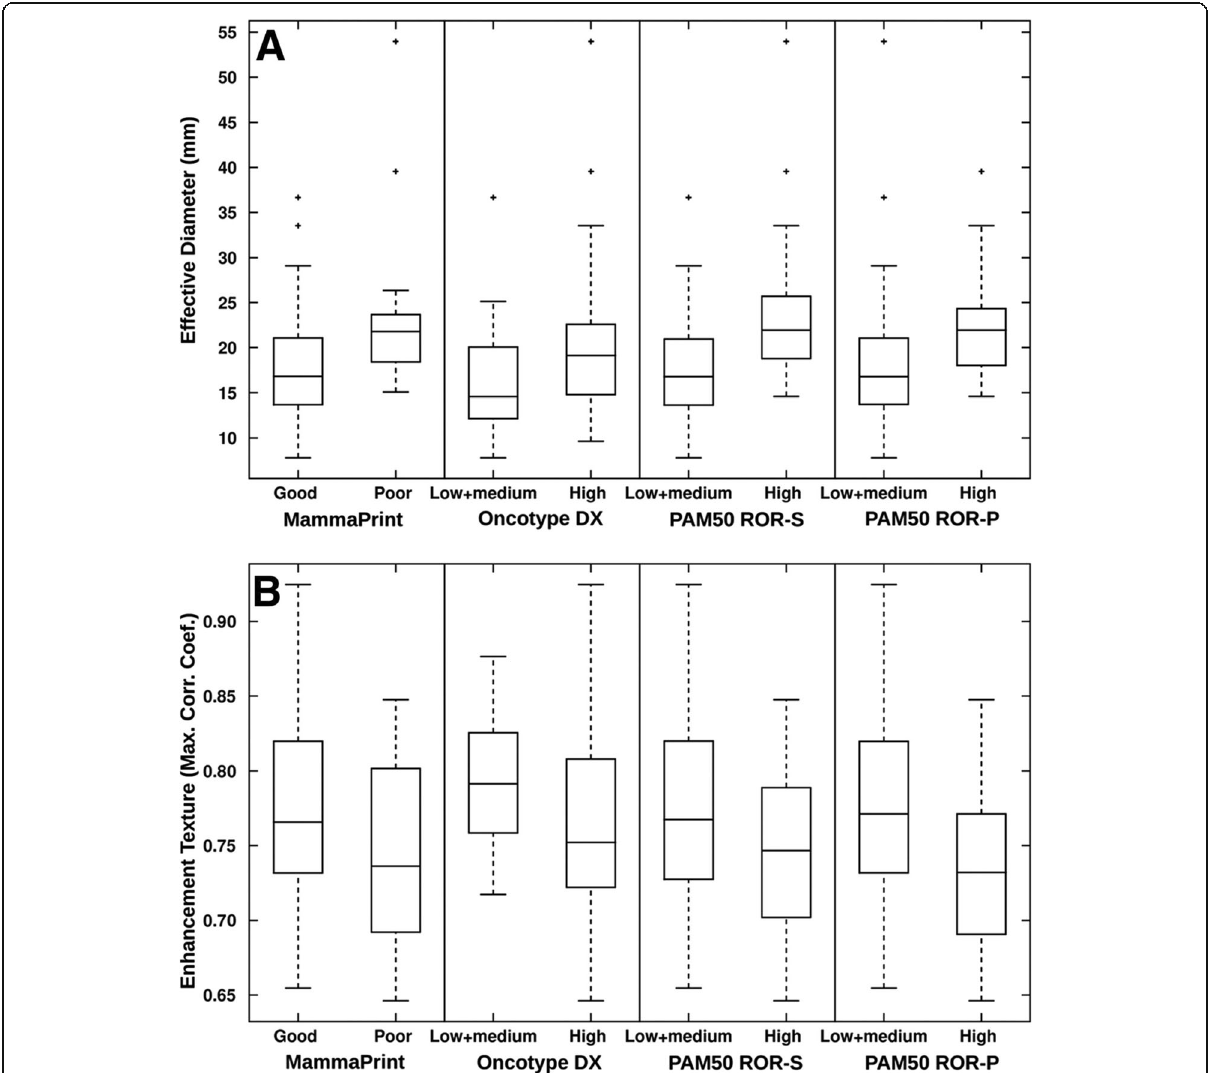
Fig. 4 Box and whisker plots show the relationship of the MRI based phenotypes of ( a ) size (effective diameter) and ( b ) enhancement texture (maximum correlation coefficient) with the recurrence predictor models of MammaPrint, Oncotype DX, PAM50 ROR-S, and PAM50 ROR-P. A positive correlation between the selected MR imaging phenotypes of size (effective diameter) and negative correlation with enhancement texture (maximum correlation coefficient) and increasing levels of risk of recurrence for MammaPrint, Oncotype DX, PAM50 ROR-S, and PAM50 ROR-P were observed. A low value of this enhancement texture feature indicates a more heterogeneous enhancement pattern. Reprinted with permission from: Radiology. 2016 Nov;281 [2]:382 – 391. Epub 2016 May 5. MR Imaging Radiomics Signatures for Predicting the Risk of